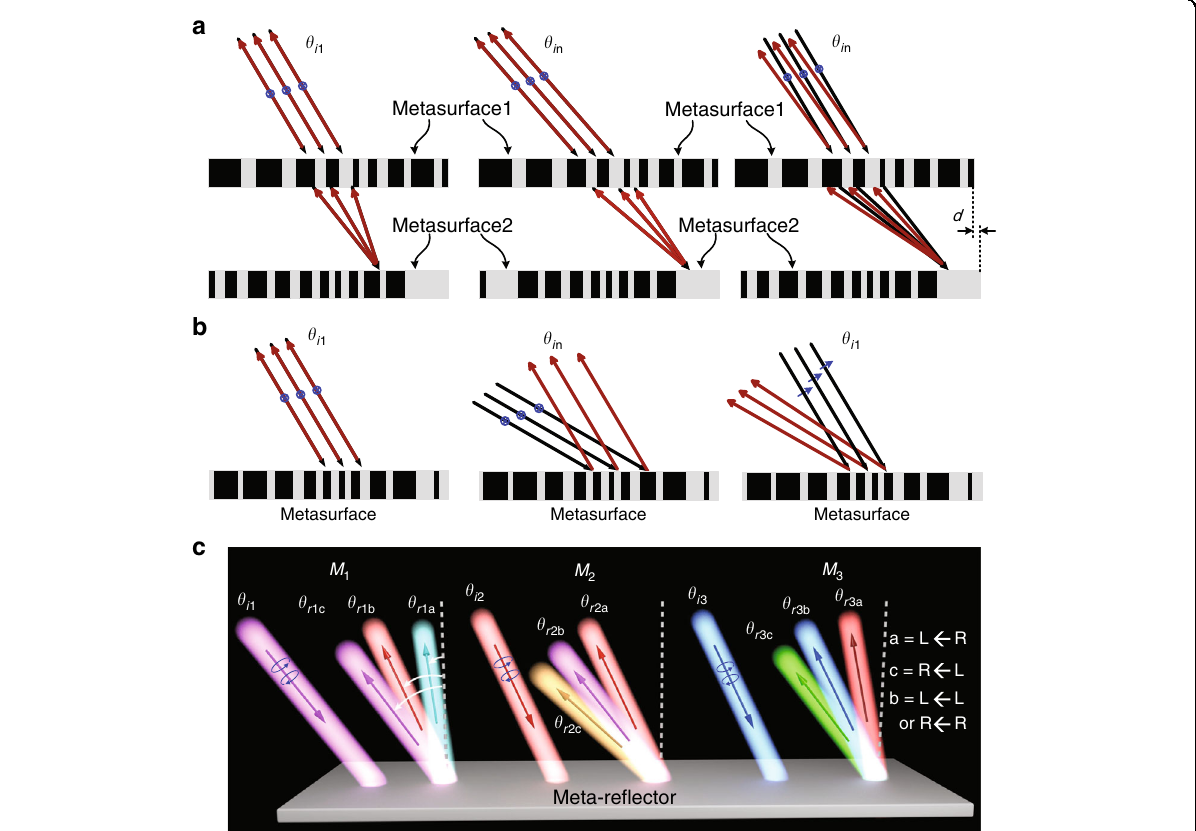
Fig. 1 Evolution of available of retrore fl ectors with their advantages and disadvantages. a Dual-metasurface retrore fl ector enabling backward re fl ection at various incident angles (left and middle panel), while relying on highly precise alignment (right panel) 10 . b Typical single-metasurface retrore fl ector only for one incidence (left and middle panel) and one polarization channel (right panel). c Angle-multiplexed super meta-re fl ector for synergized re fl ections and retrore fl ections at three excitation momentums of M 1 , M 2 , and M 3 , advancing a big step relative to previously reported ones only for retrore fl ection. The wave is incident along three different angles of θ i1 , θ i2 , and θ i3 , four re fl ections with three different angles of θ ra , θ rb , and θ rc ( θ ra < θ rb < θ rc ) are expected along four CP channels at each incidence. Here, the subscripts ‘ a ’ and ‘ c ’ indicate the channel of LR (RCP to LCP) and RL (LCP to RCP), respectively, while ‘ b ’ represents the channel of LL (LCP to LCP) or RR (RCP to